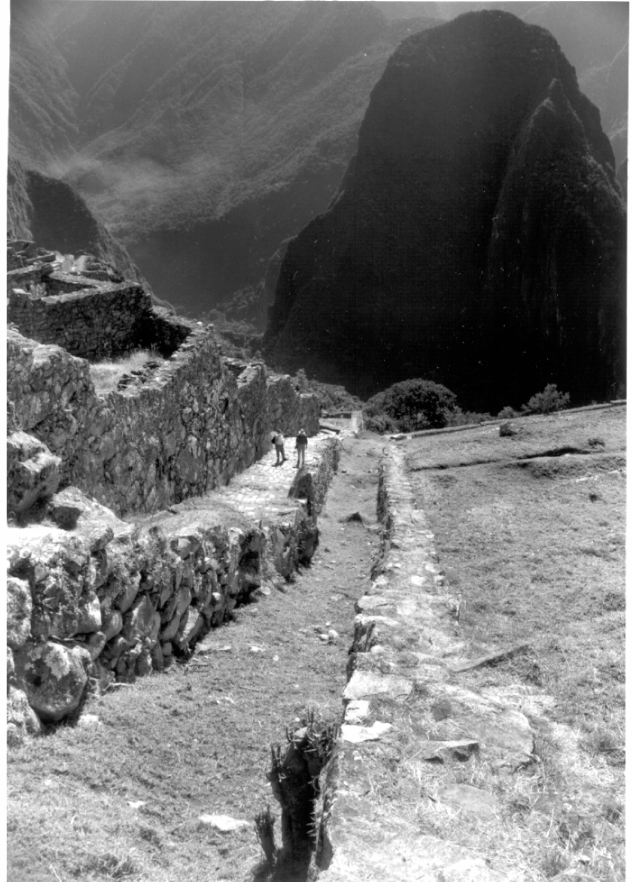
Figure 8. The main drain or “dry moat” was the route for wastewater to exit the Machu Picchu site. The wastewater flowed to the rainforest below, where lush vegetation minimized the erosive potential of the